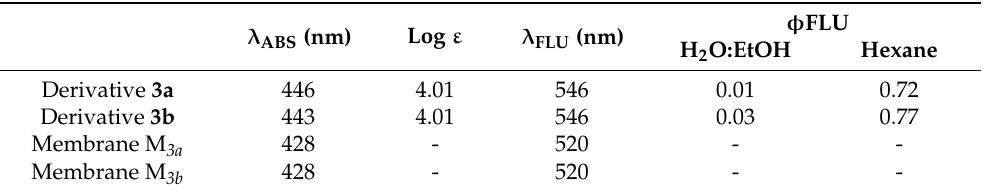
Table 2. Parameters determined by UV-VIS absorption and fluorescence spectroscopies for 3a and 3b naphthalimide in solution and M 3a and M 3b membrane